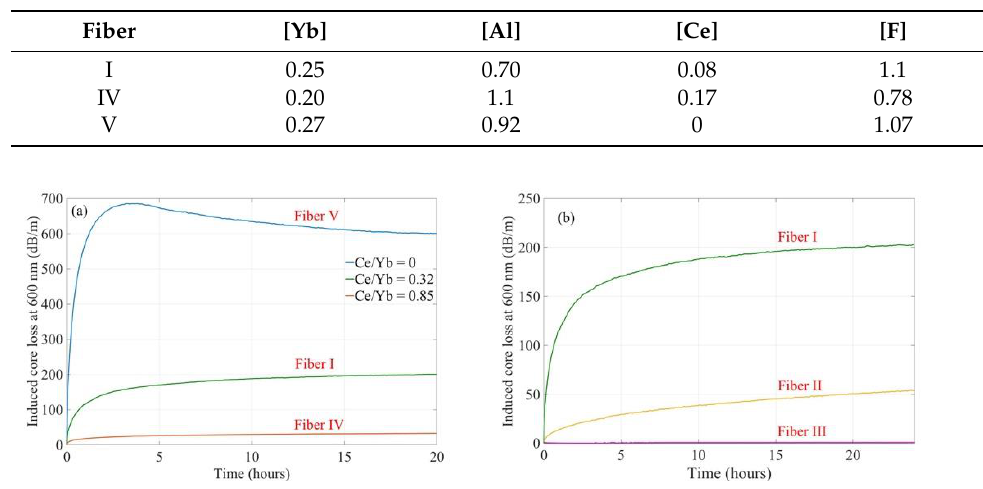
Table 2. Composition of test fibers (at.%).